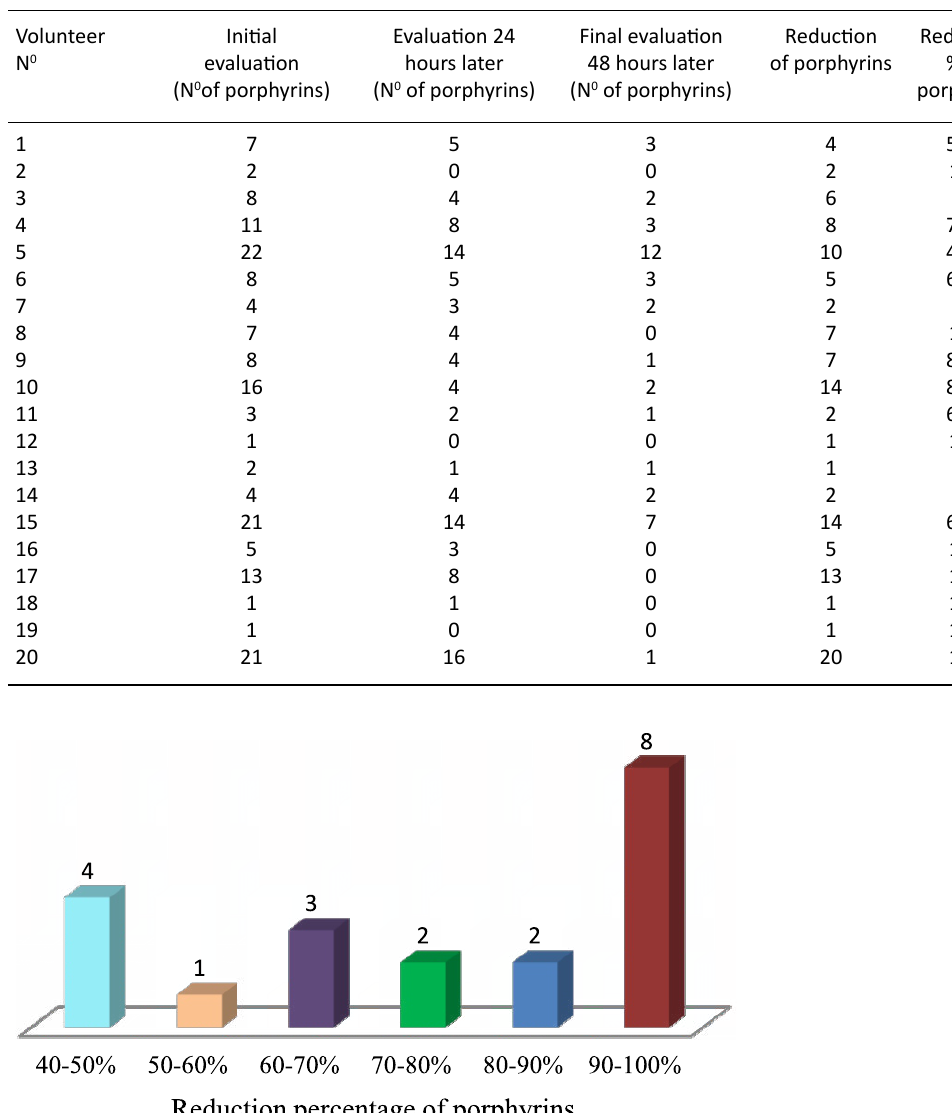
Fig. 6. Number of adolescents vs. reduction percentage of Porphyrins.